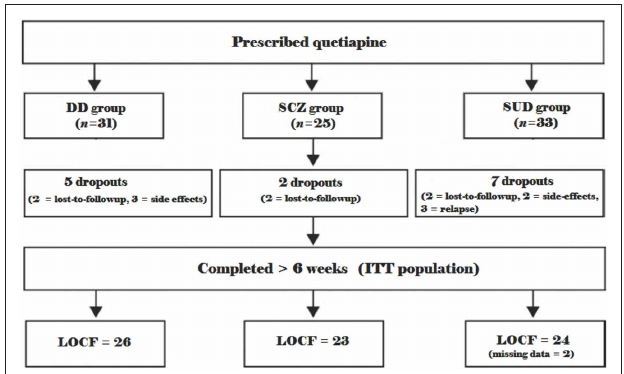
Table 1 | Sociodemographic